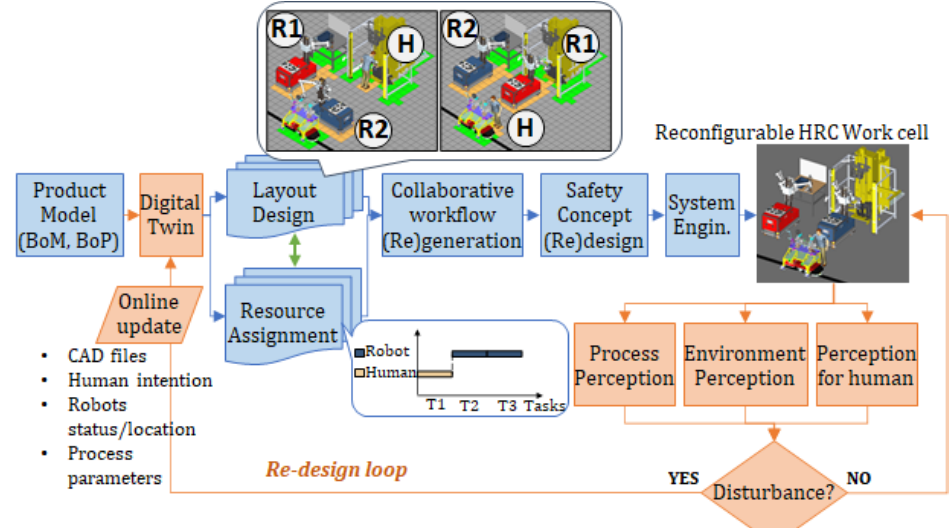
Figure 4. Proposed paradigm on the design workflow of HRC applications.